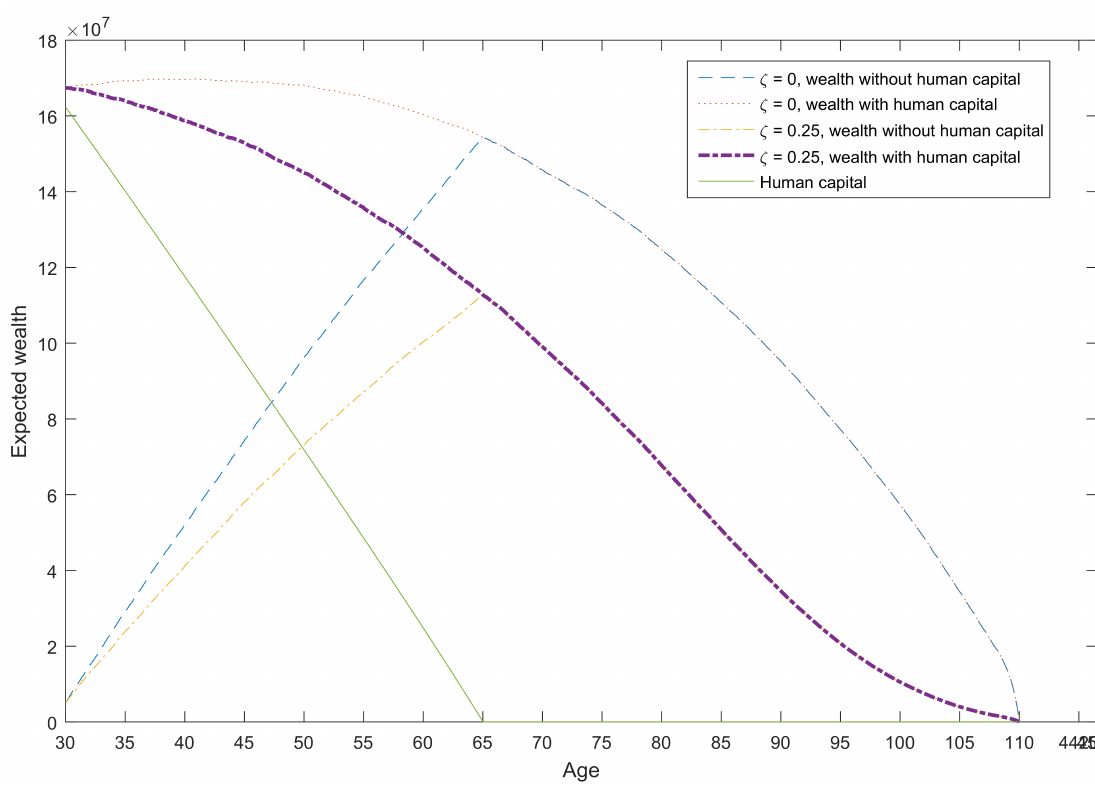
Figure 3. Expected